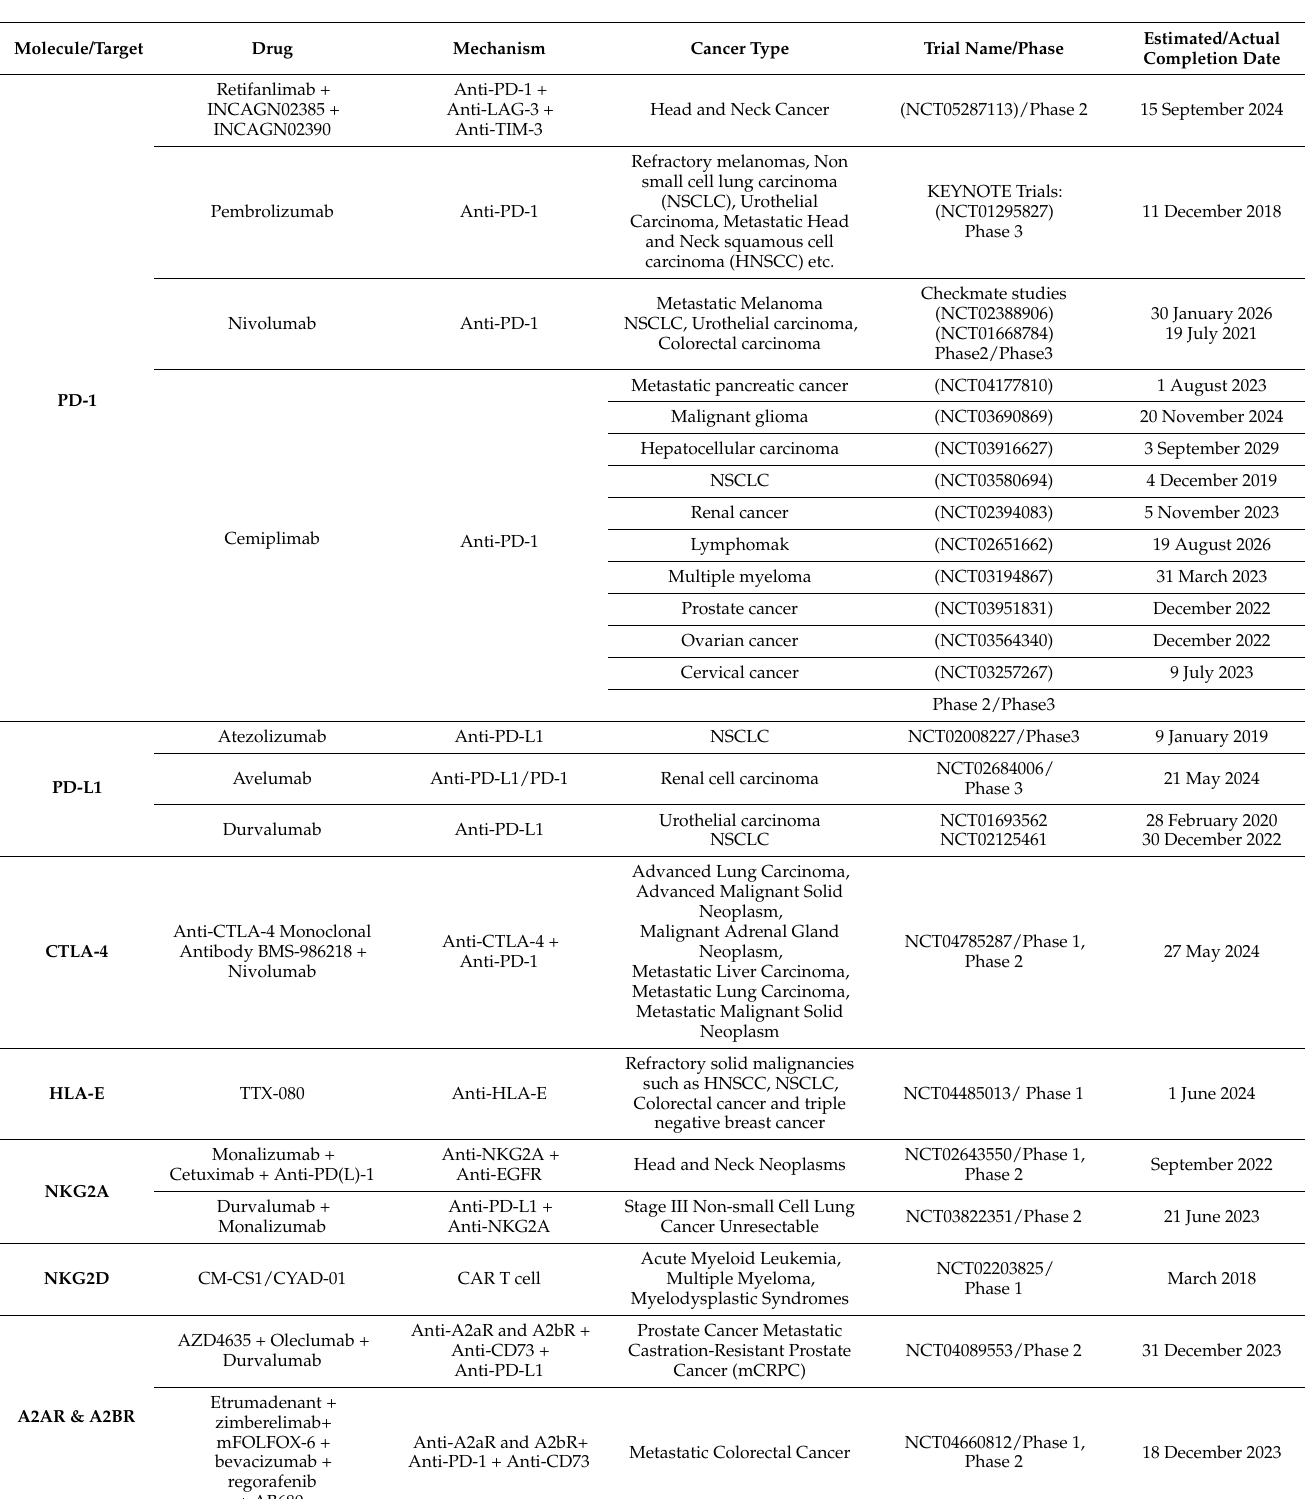
Table 1. Important clinical trials pertaining to the immune checkpoint targets mentioned in this